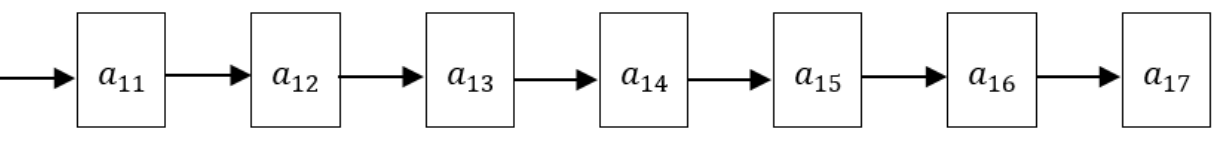
Figure 3. Assembly line with seven workstations.